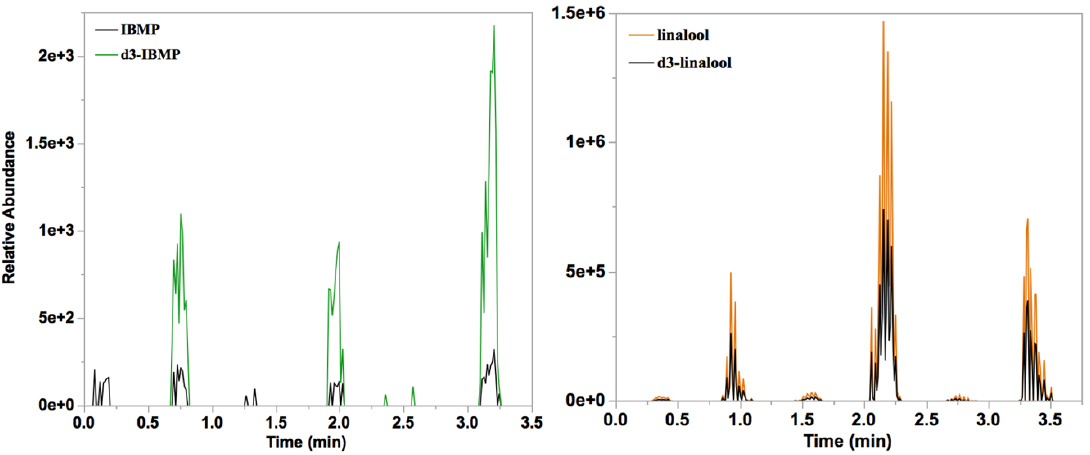
Figure 4. DART-Orbitrap-MS(-MS) chronograms of extracted ions for ( left ) IBMP 167 - > 124.0632 m / z and d 3 -IBMP 170 - > 127.0818 m / z of a Cabernet Sauvignon homogenate (average concentration = 20 ng / L by SPMESH sheet-DART-MS-MS; 24 ng / L by SPME-GC-MS) and ( right ) linalool 137.1326 m / z and d 3 -linalool 140.1512 m / z in Muscat of Alexandria juice (386 µ g / L by SPMESH sheet-DART-MS; 353 µ g /